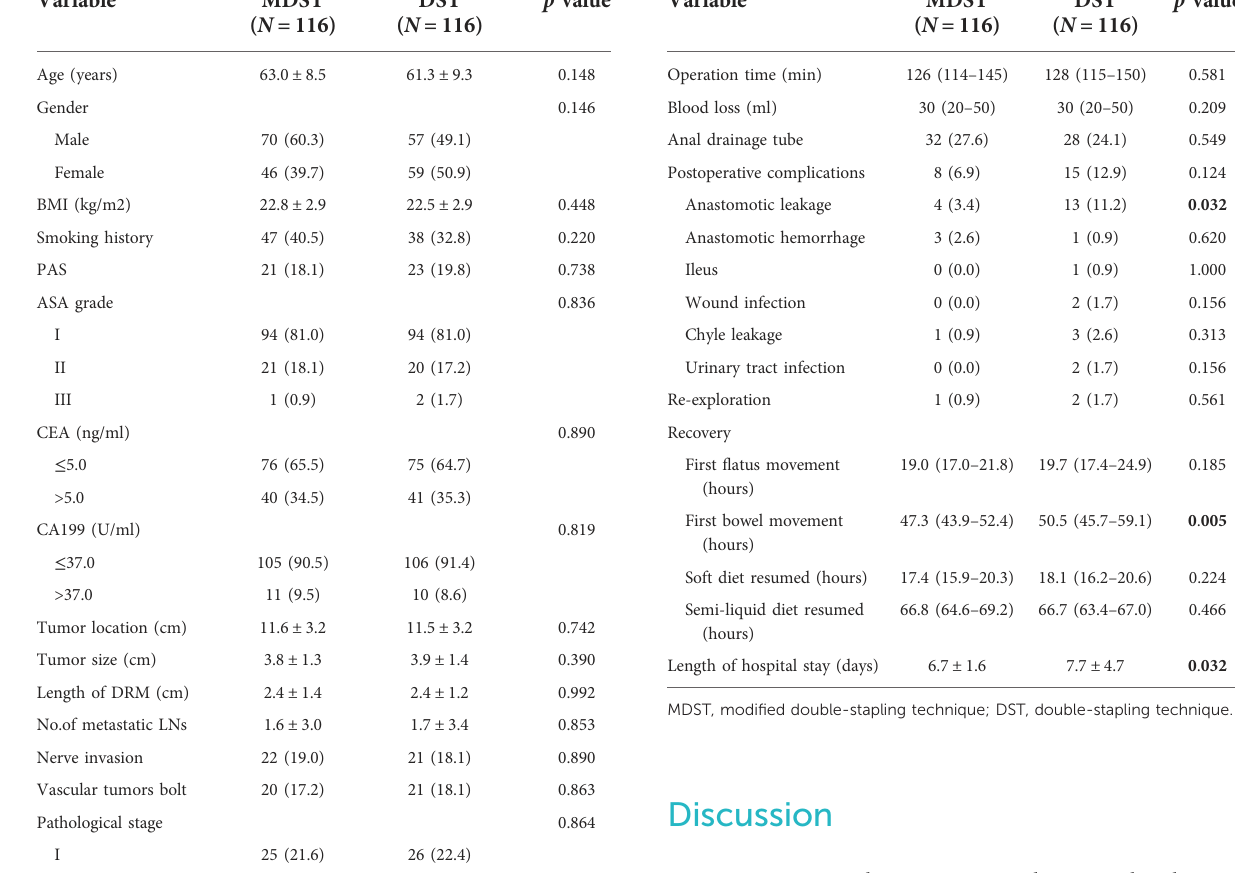
TABLE 1 Comparison of patient characteristics and pathologic outcomes.